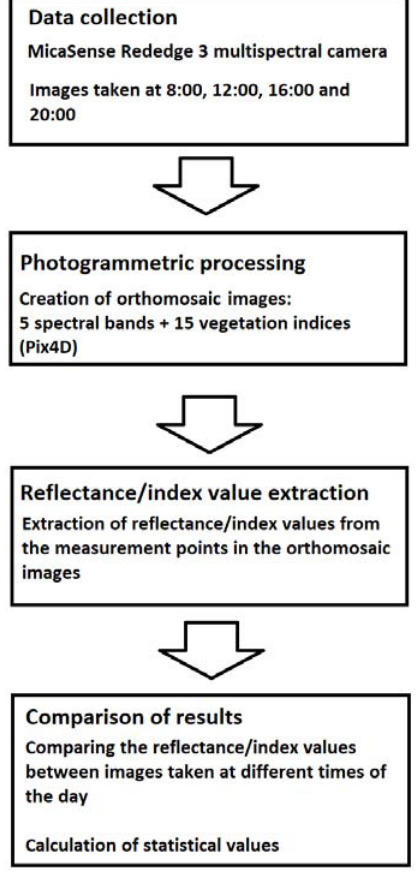
Figure 5. Process diagram of the work steps in this study.